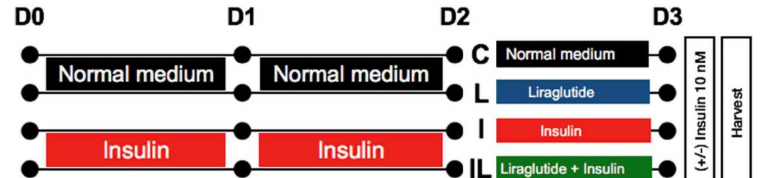
Figure 1. Schematic diagram of the experiment. Human neuroblostoma cells, SH-SY5Y, were incubated with normal medium or medium with 100 nM insulin for 48 h to induce insulin resistance. After 48 h, the cells without insulin induction were further treated with normal medium (C) or 500 nM liraglutide (L), while the insulin-resistant cells were further treated with 100 nM insulin (I) or 500 nM liraglutide (IL) for 24 h. Before harvesting cells, each group was subdivided into 2 groups (stimulated with 10 nM insulin or left unstimulated for 30 min). D0, D1, D2, and D3 represent the experimental days as day0, day1, day2, and day3, respectively, after cell seeding.